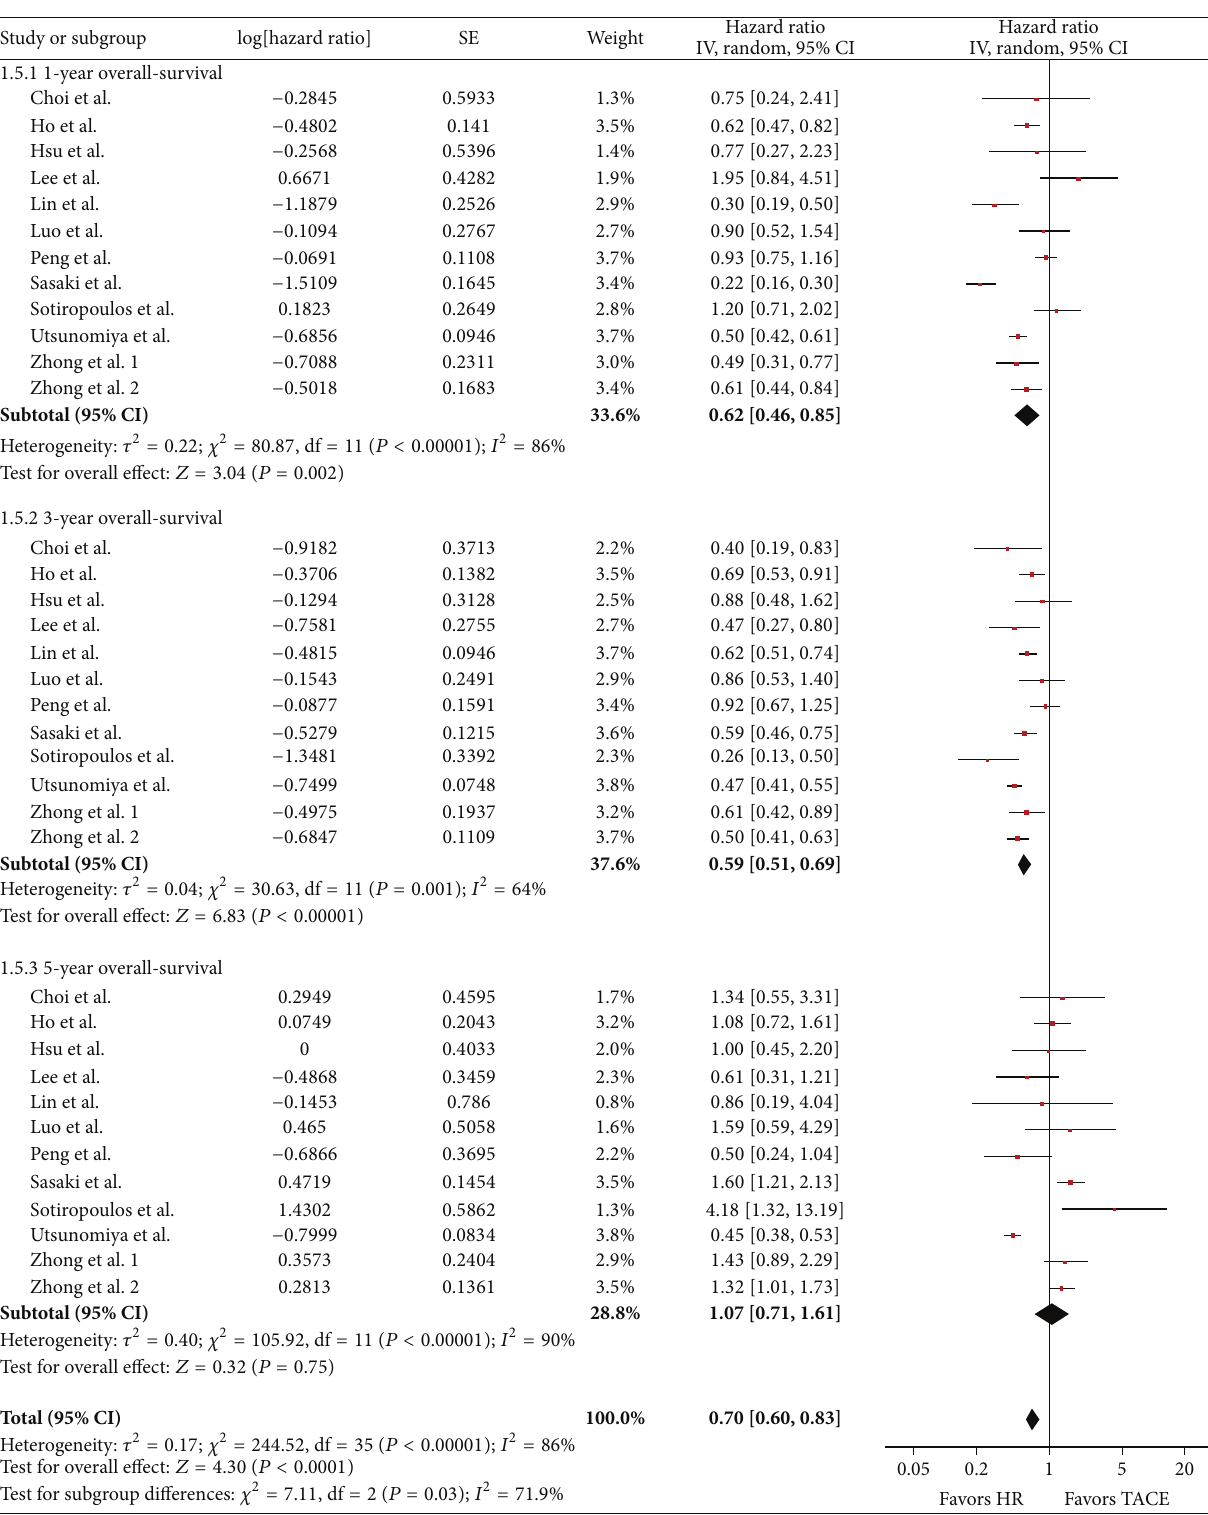
Figure 4: Forest plot illustrating subgroup analysis of short- and long-term overall-survival comparing hepatic resection to TACE. The center of each square represents the hazard ratio for individual trial and each horizontal line represents its 95% CI. The size of the box is directly related to the “weighting” of the study. The center of the diamond represents the pooled hazard ratio and the width represents its 95% CI. For each subgroup (1, 3, and 5 years), the sum of the statistics is represented by the first three diamonds. The last diamond illustrates the overall result of the